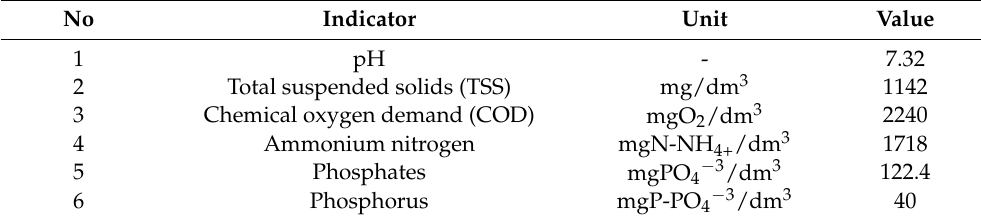
Table 3. Characteristics of the reject water from non-sonicated digestion sludge. No